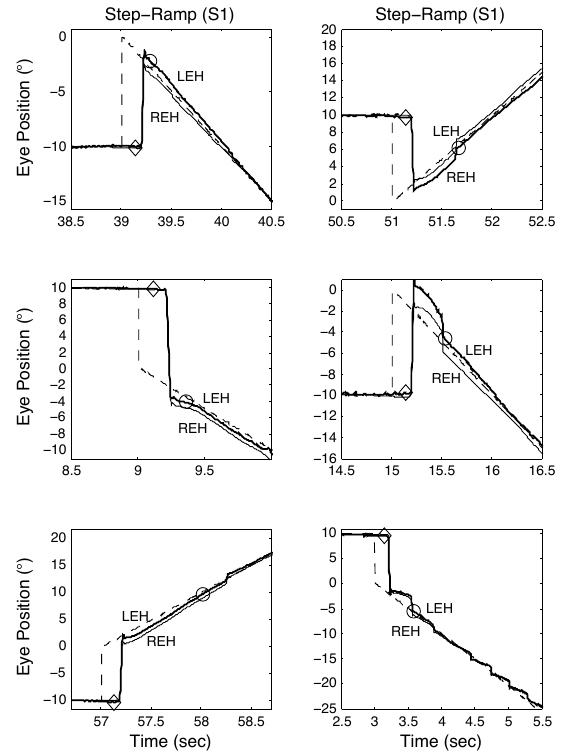
Figure 4. Examples of SR responses from S1 demonstrating both classical and other types of response, including those containing disconjugate saccades. See text for descriptions. In this and the following figures, the time of pursuit onset is indicated by a diamond, the time the target is acquired, by a circle, and the fixating eye by the heavy tracing. All position and time scales were chosen to best illustrate the components of the response in each panel.